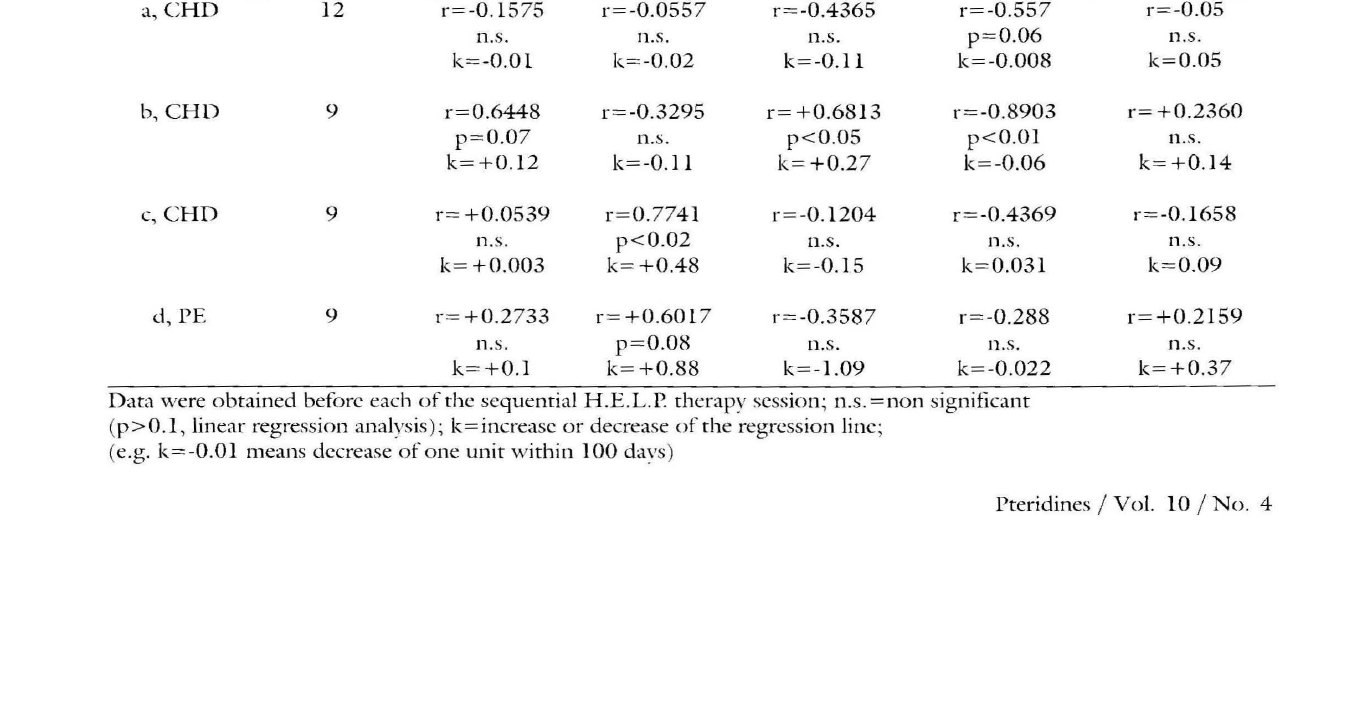
Table 3. Long-term effect ofH.E.L.P. therapy in four individual subjects Patient